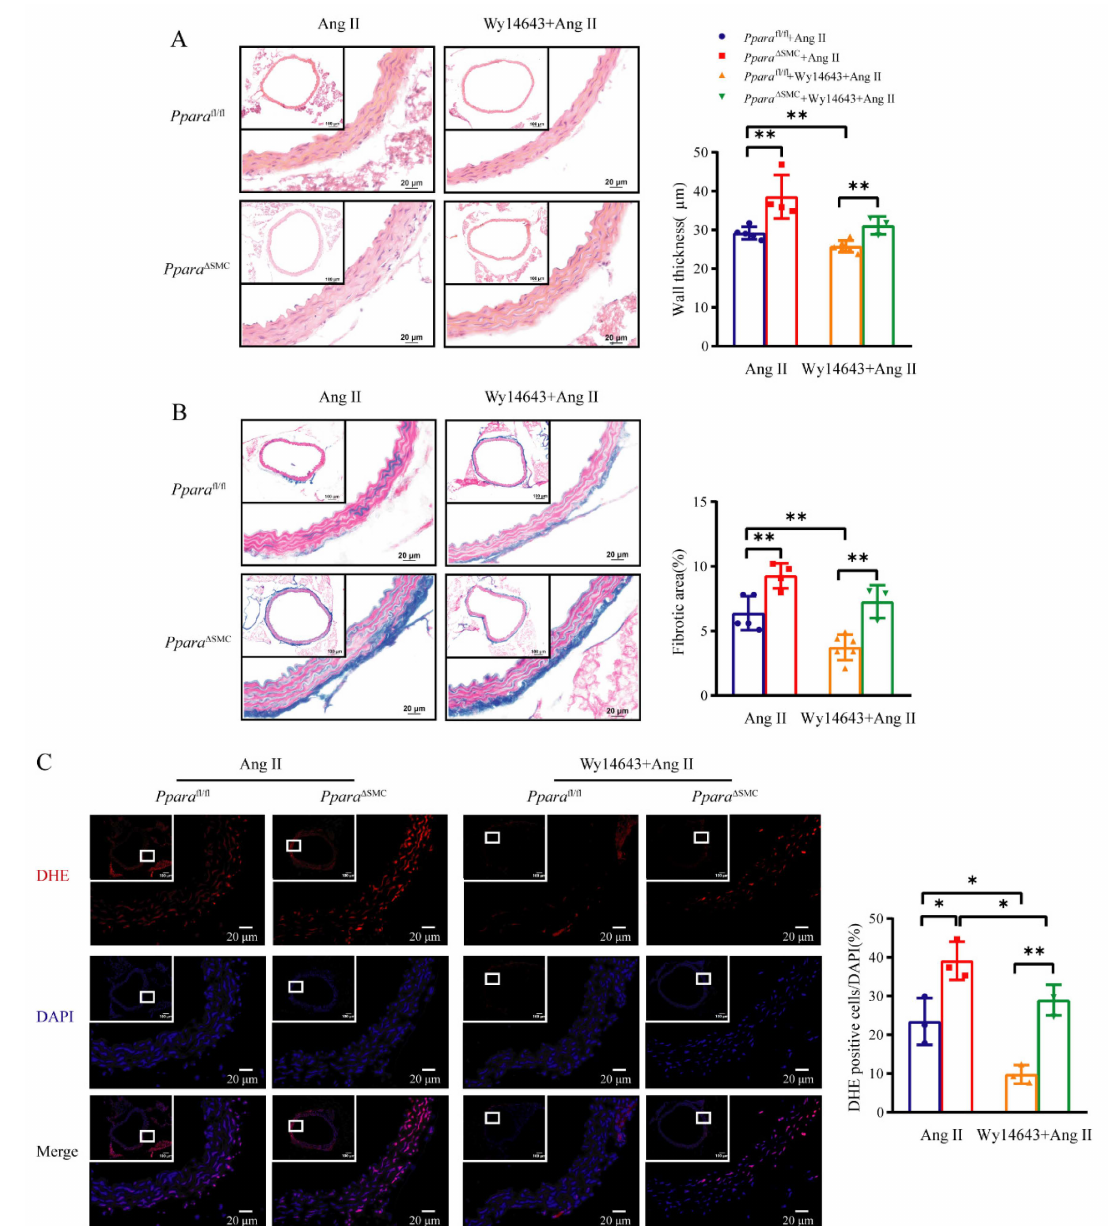
Figure 6. Activation of PPAR α by Wy14643 improved Ang II − induced vascular remodeling and ROS production. Representative images and analysis of hematoxylin and eosin (H&E) staining ( A ), Masson’s trichrome staining ( B ), and dihydroethidium (DHE) staining ( C ) for aortic cross sections from Ppara ∆ SMC and Ppara fl/fl mice with Wy14643 feeding and Ang II infusion. Scale bar = 20 µ m ( n = 3–6, two-way ANOVA). Data are means ± SEM. * p < 0.05, ** p < 0.01 between